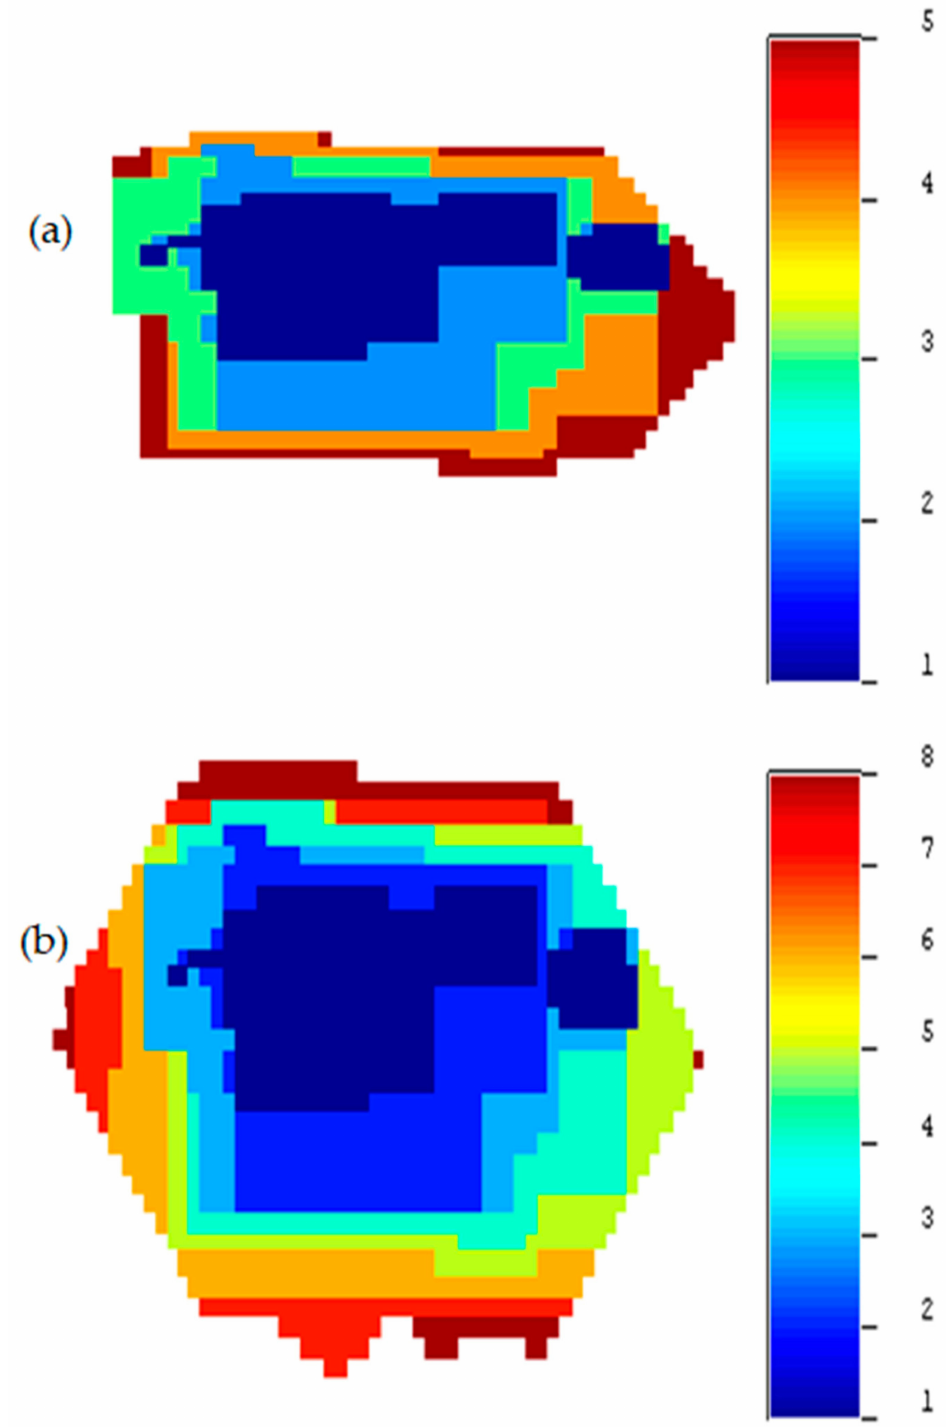
Figure 6. ( a ) Section view of the ultimate pit for 5 periods. ( b ) Top view of ultimate pit for 8